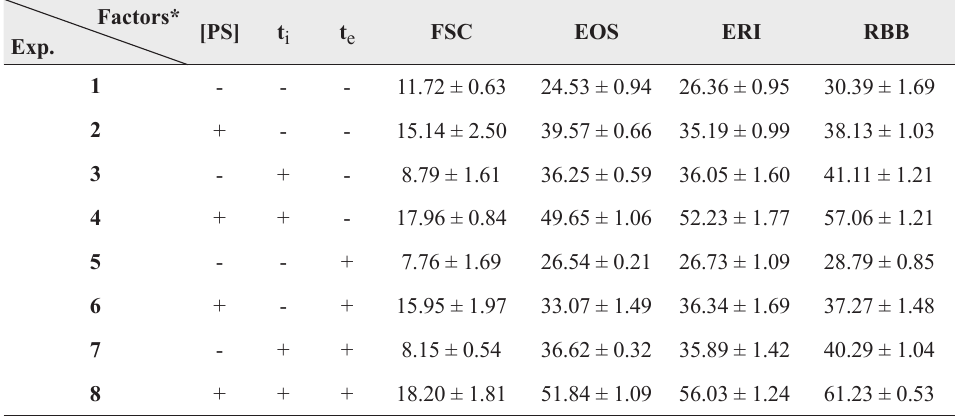
Average percentage of death for A. salina with the photosensitizers irradiated with